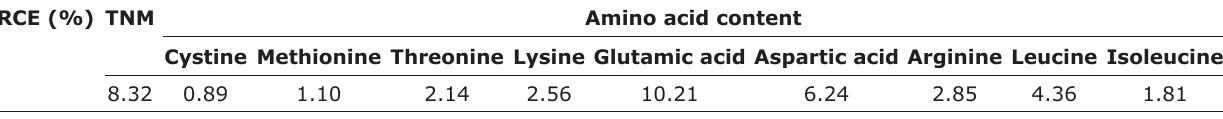
Table-3: Content of the ovine RCE in terms of nitrogenous matter (% of DM) and amino acids (% of TNM). RCE (%) TNM Amino acid